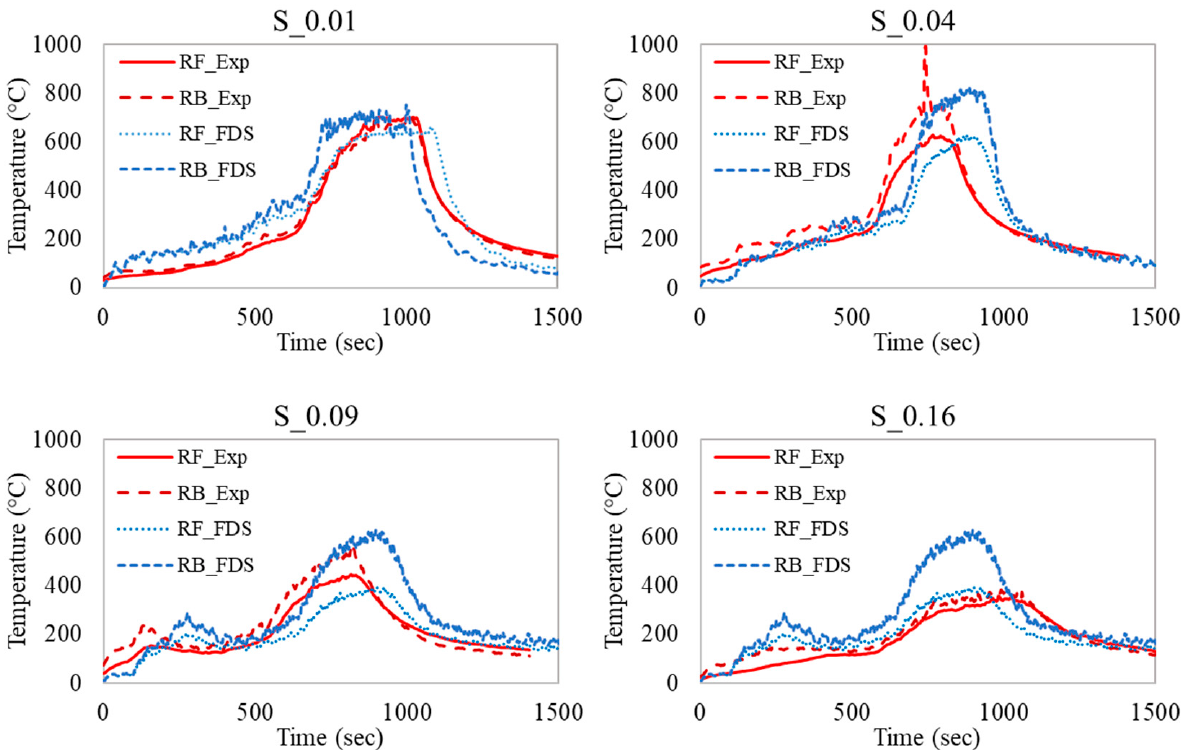
Figure 19. Gas layer temperature for slot cases.